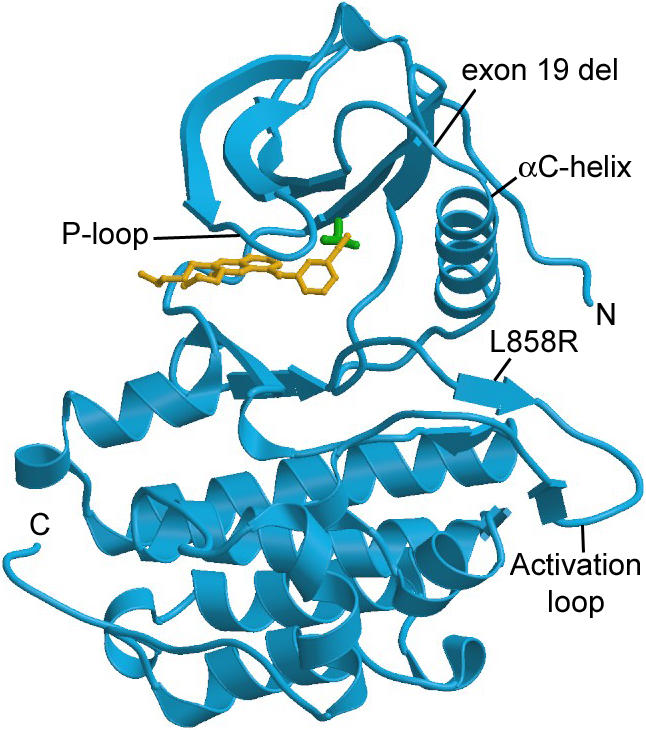
Erlotinib Bound to the EGFR Kinase DomainSchematic representation of the wild-type EGFR tyrosine kinase domain (cyan) bound to erlotinib (orange) from the Protein Data Bank (http://www.rcsb.org/pdb/) entry 1M17. The threonine 790 side chain is shown in green. The positions of the phosphate-binding loop (P-loop), the αC-helix, and the activation loop (conserved structural features in kinase domains) are shown for reference. Sites of common lung-cancer-associated drug-sensitive mutations (exon 19 deletion [del] and L858R) are also depicted.(Figure: Nikola Pavletich, Structural Biology Program, Memorial Sloan-Kettering Cancer Center)